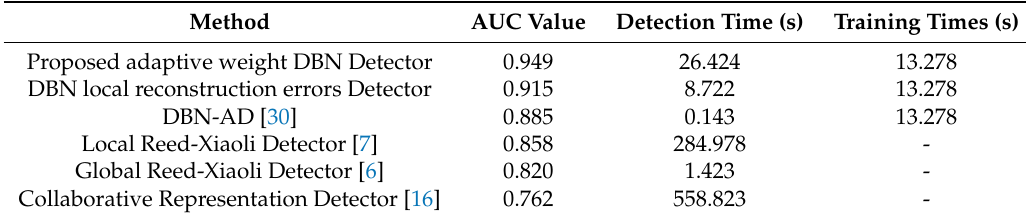
Table 4. AUC values and processing time of different methods for the synthetic HSI image of San